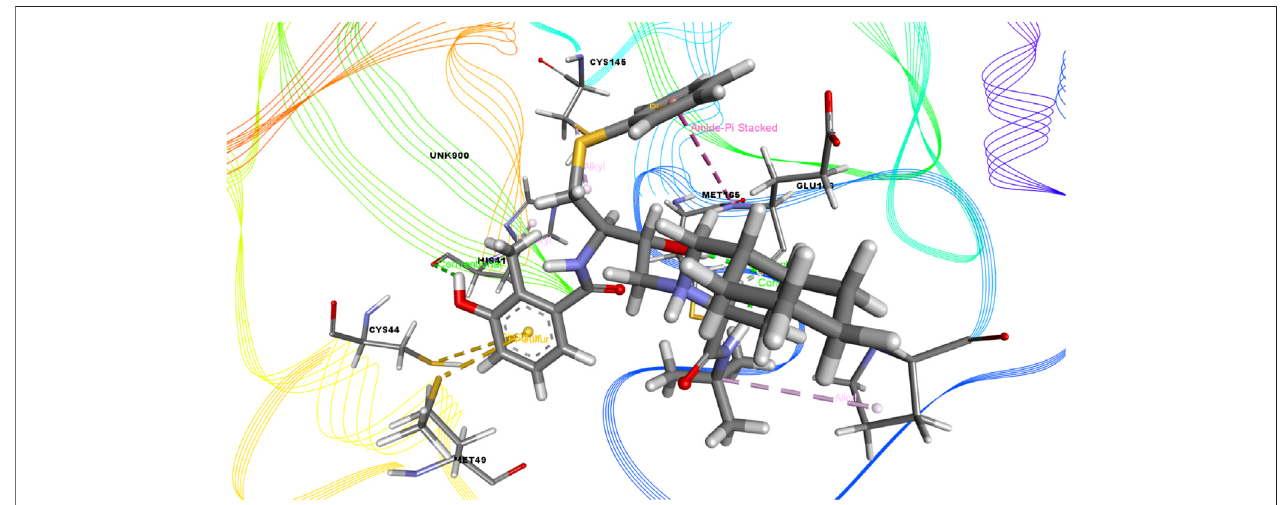
FIGURE 7 | 3D interactions of Lopinavir with the active site of SARS-CoV-2 main protease (PDB ID: 6W63).